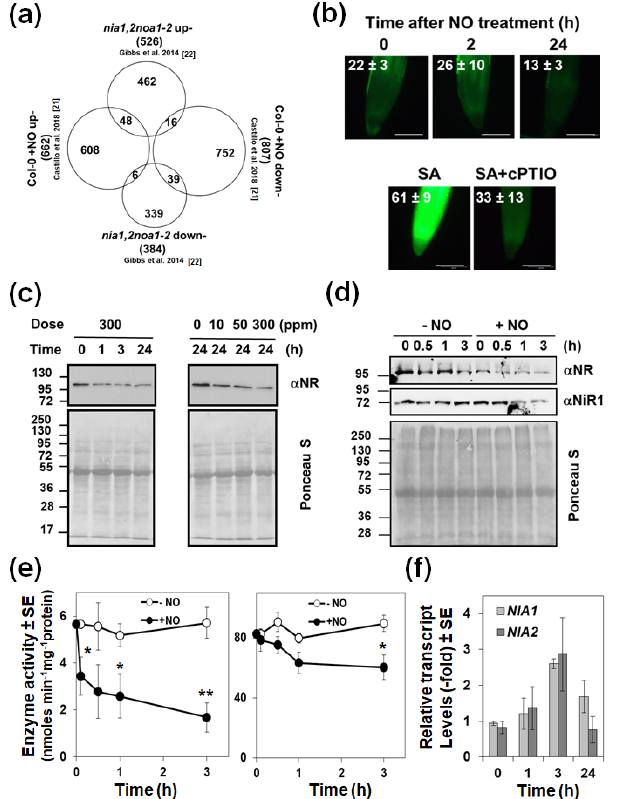
Figure 1. Exogenous NO negatively mimics endogenous NO deficiency. ( a ) Venn diagram showing the overlaps between up and down-regulated genes in NO-deficient nia1,2noa1-2 mutant plants and wild-type plants exposed to 300 ppm of NO gas. ( b ) Endogenous NO levels in wild-type roots were analyzed by treatment with DAF-FM DA fluorophore and images are representative of each condition. Positive and negative controls with salicylic acid (SA)-treated and NO scavenger cPTIO-treated roots, respectively, are shown. Values are the mean ± standard error of three independent replicates. Scale bars correspond to 100 µ m. ( c ) Levels of NR protein in plants exposed to increasing NO concentrations and different times were detected by Western blot with an anti-NR antibody. ( d ) NR and NiR1